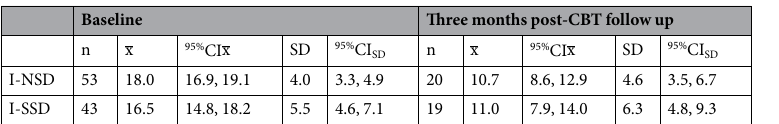
Table 3. Baseline-three months post-cognitive behavioural therapy follow-up insomnia severity index scores for each insomnia subtype group. Note: CBT: Cognitive behavioural therapy; CI: Confidence interval; I-NSD: Insomnia with normal sleep duration; I-SSD: Insomnia with short sleep duration; SD: Standard